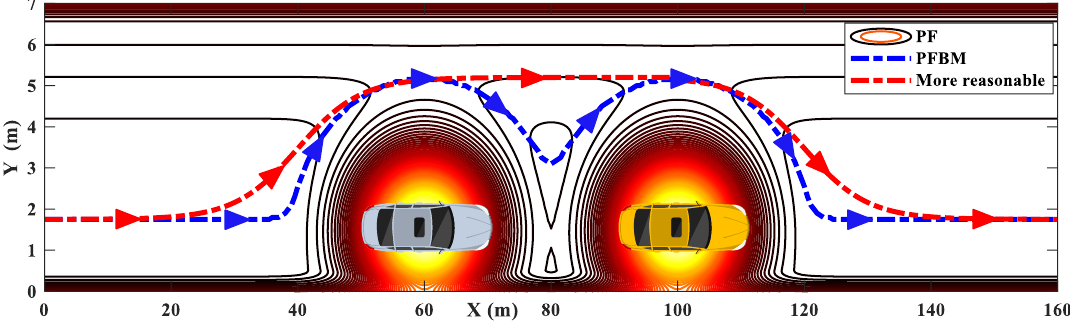
Figure 5. A driving scenario with two obstacle